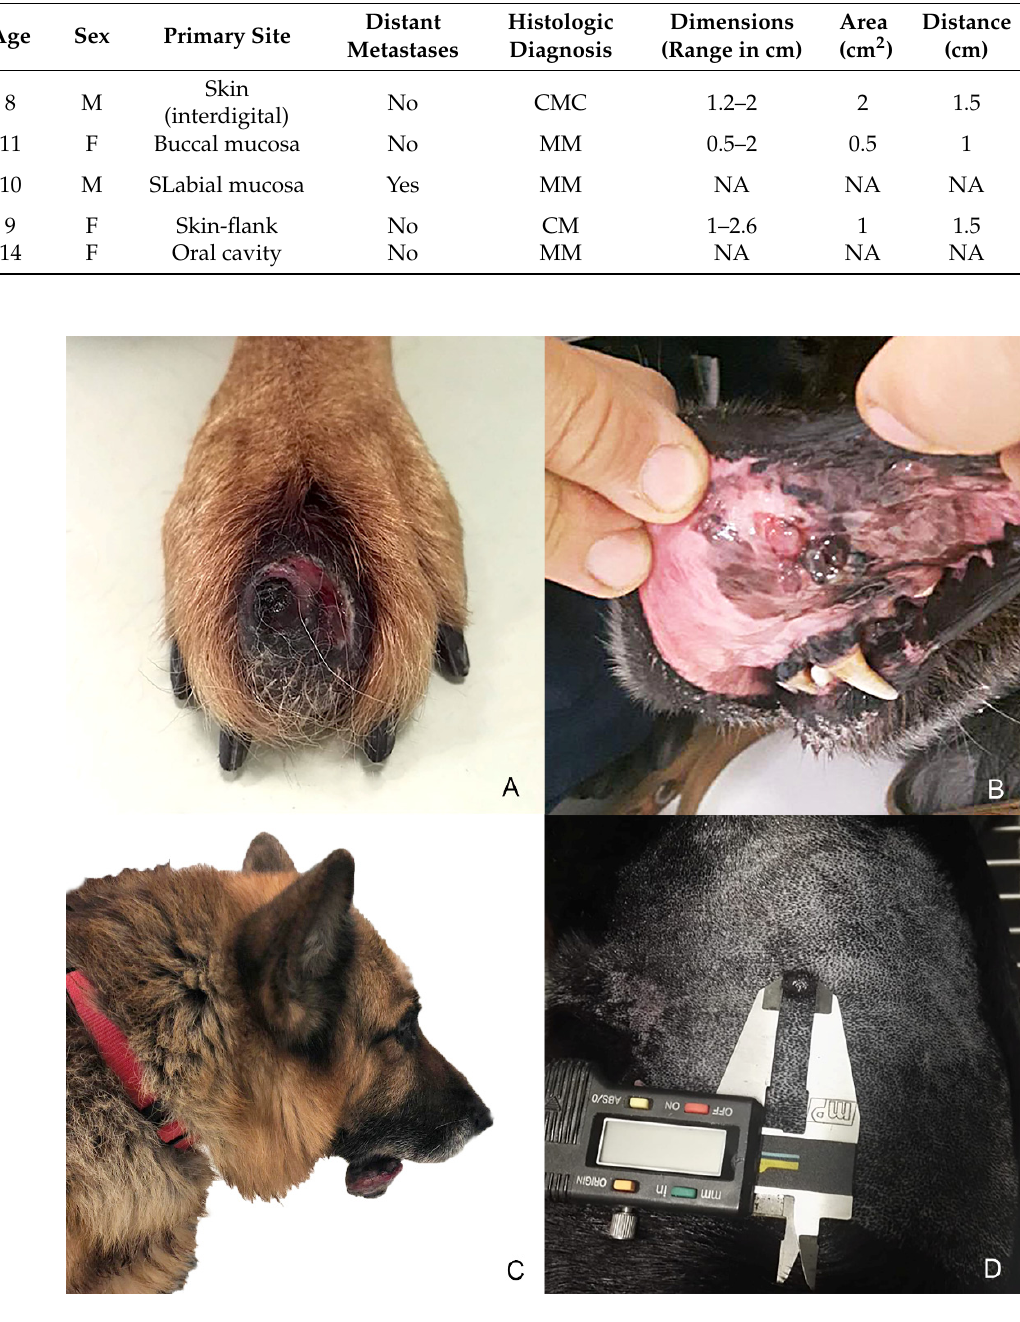
Figure 1. Anatomical localization of selected melanocytic tumors. ( A ) Case n. 1—Interdigital cutaneous melanocytoma; ( B ) Case n. 2—Mucosal (buccal) melanoma; ( C ) Case n. 3—Melanoma arising from the mucous side of the lower lip with lymph node metastases; ( D ) Case n. 4—Cutaneous melanoma of 1 cm of diameter on the left flank area.